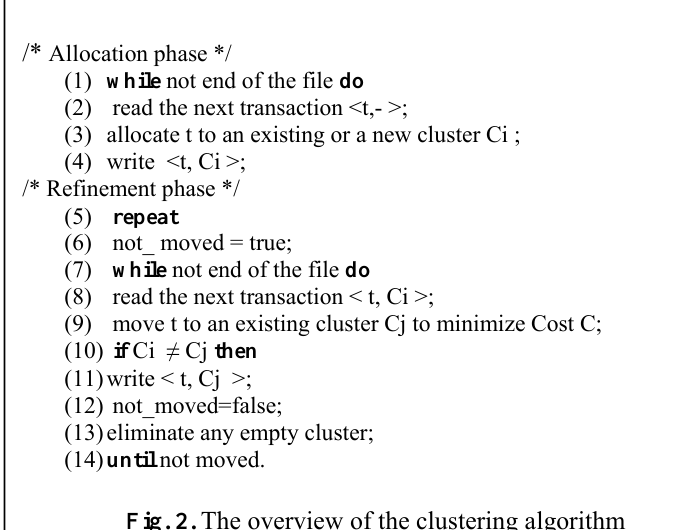
Fig. 2. The overview of the clustering